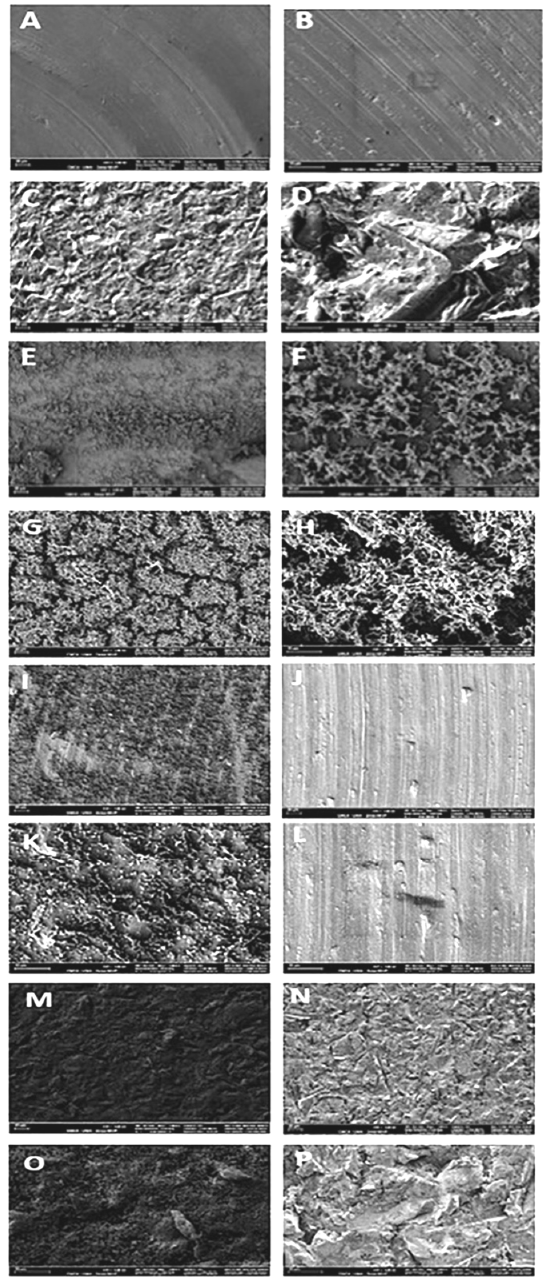
Figure 7. Samples of SEM imaging: ( A ) pristine M disc (1000 × ); ( B ) pristine M discs (5000 × ); ( C ) pristine MRS disc (1000 × ); ( D ) pristine MRS disc (5000 × ); ( E ) intact contaminated untreated M disc (1000 × ); ( F ) intact contaminated untreated M disc (5000 × ); ( G ) intact contaminated untreated MRS disc (1000 × ); ( H ) intact contaminated untreated MRS disc (5000 × ); ( I ) untreated half of contaminated M disc (1000 × ); ( J ) group 4 treated half of contaminated M disc (1000 × ); ( K ) untreated half of contaminated M disc (5000 × ); ( L ) group 4 treated half of contaminated M disc (5000 × ); ( M ) untreated half of contaminated MRS disc (1000 × ); ( N ) group 4 treated half of contaminated MRS disc (1000 × ); ( O ) untreated half of contaminated MRS disc (5000 × ); ( P ) group 4 treated half of contaminated MRS disc (5000 ×